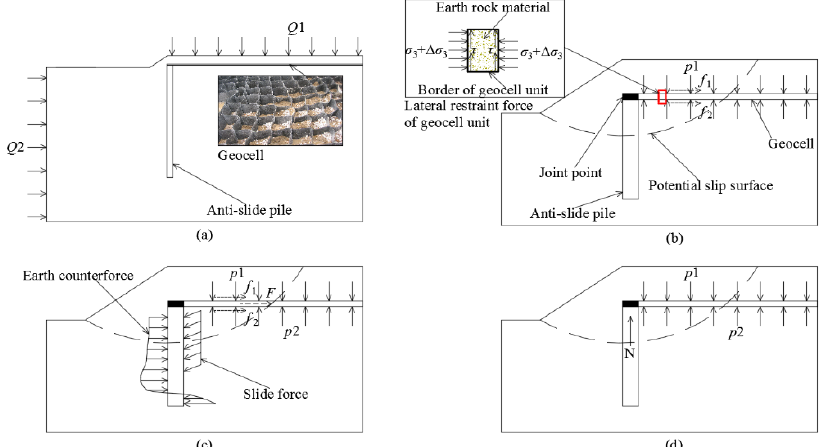
Figure 1. The proposed theoretical model for investigating an anti-slide pile and geocell system for riverbank slope enhancement. ( a ) Detailed design of anti-slide pile with geocells (Q1: Surcharge loading imposed on top of the riverbank slope; Q2: Water pressure imposed on the left boundary of the riverbank slope); ( b ) Loading condition of the geocell layer; ( c ) Loading condition of the anti-slide pile; and ( d ) Load transfer between the anti-slide pile and geocell.